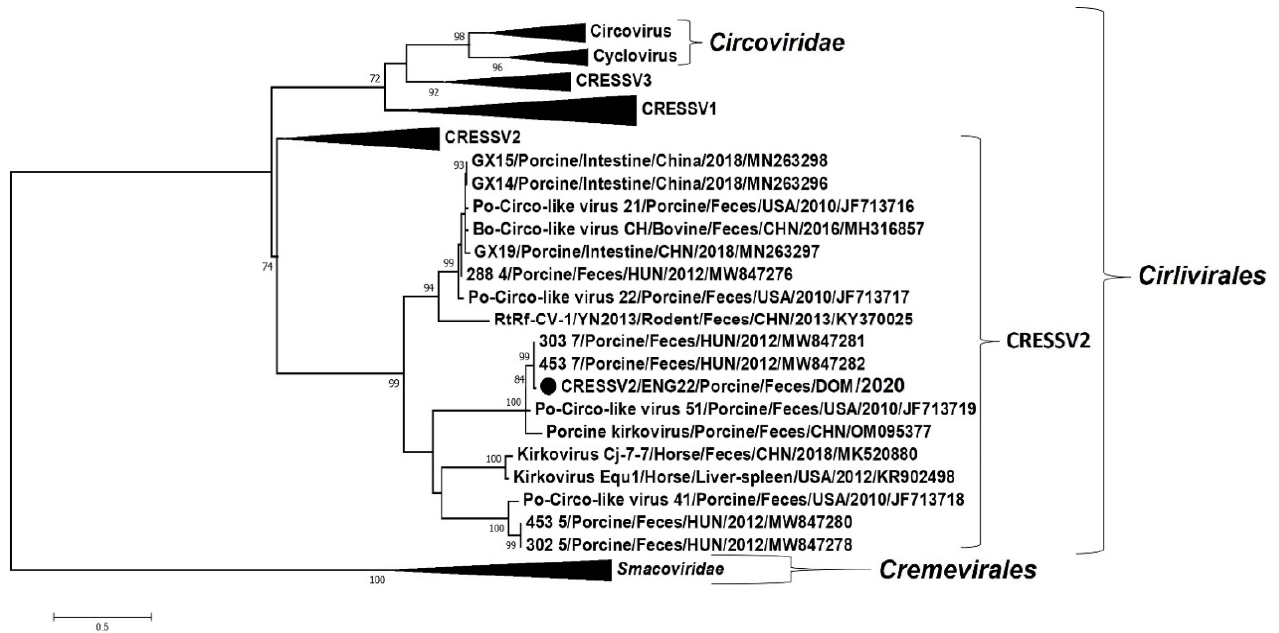
Figure 4. Phylogenetic analysis of the putative replication associated (Rep) protein of porcine-associated circular Rep-encoding single-stranded (CRESS) DNA virus CRESSV2/ENG22 (shown with black circle) with those of viruses belonging to the orders Cremevirales and Cirlivirales . The virus name/source: animal/sample/country/year/GenBank accession number are shown for the CRESSV2 DNA viruses. Scale bar, 0.5 substitutions per amino acid residue. Bootstrap values of < 70 are not shown.